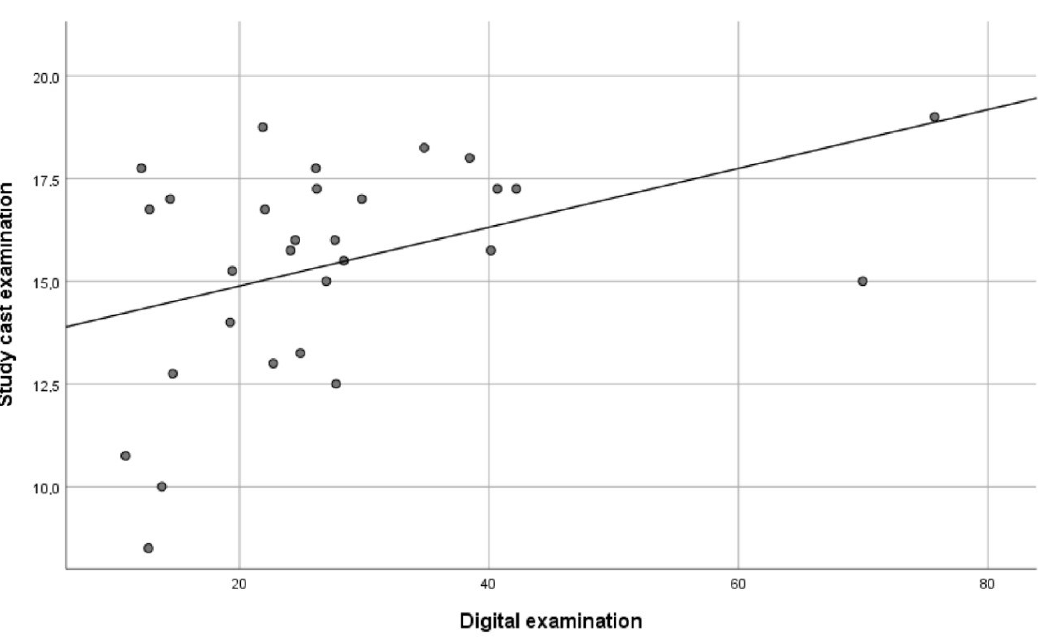
Figure 5. Scatterplot explaining the relationship between the total amount of occlusal contacts in the clinical examination and the total amount of occlusal contacts in the study cast examination ( n = 29). Every dot represents one of the included participants ( p < 0.05).